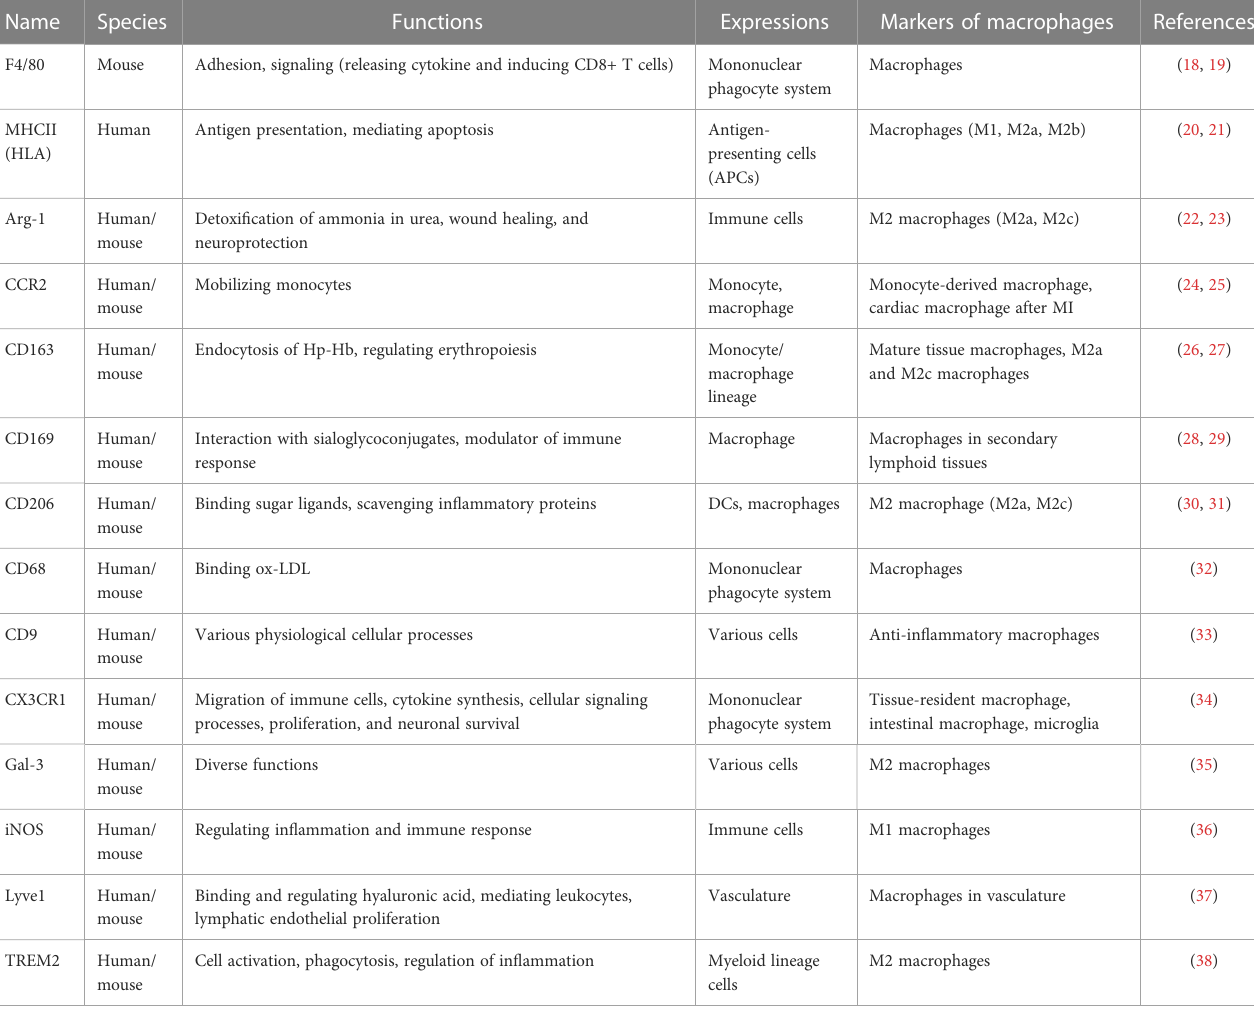
TABLE 1 A list of classical and novel markers of the